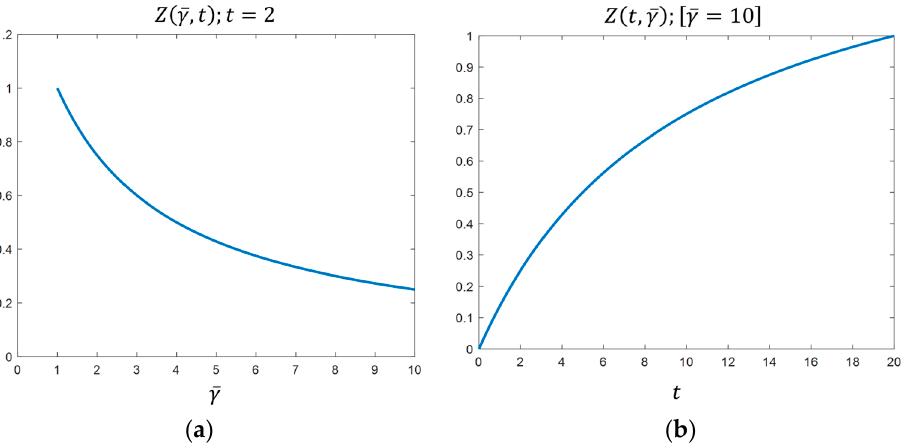
Figure 1. Budget value 𝛾 assigned to the AC on product differentiation